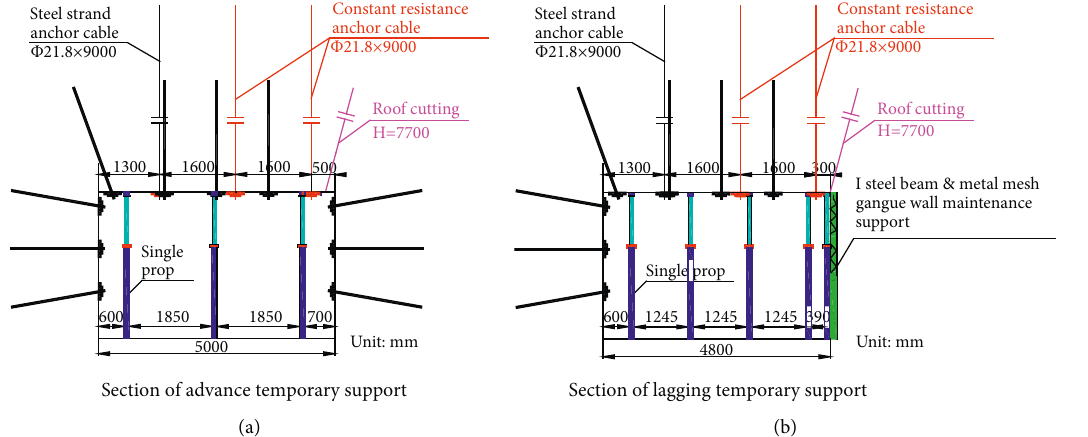
Figure 12: Forward and rear support design of 8304 working face. (a) Section of advance temporary support. (b) Section of lagging temporary support.